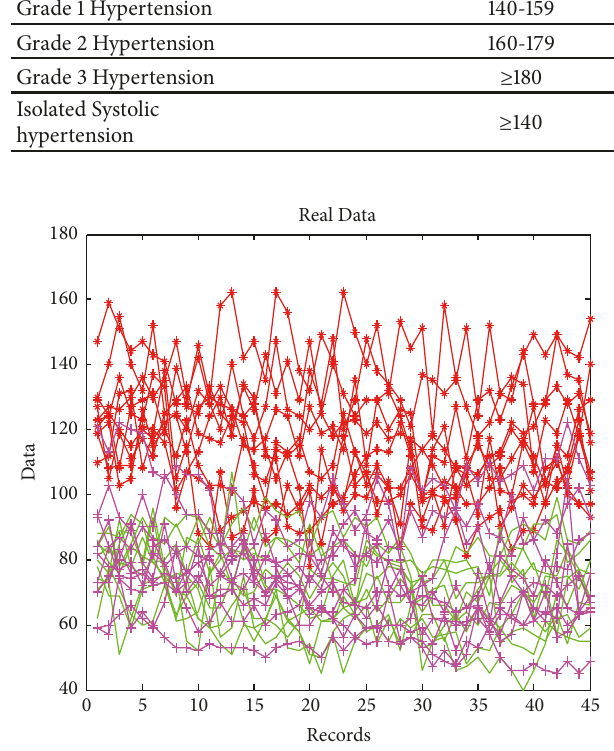
Figure 2: Real data of the